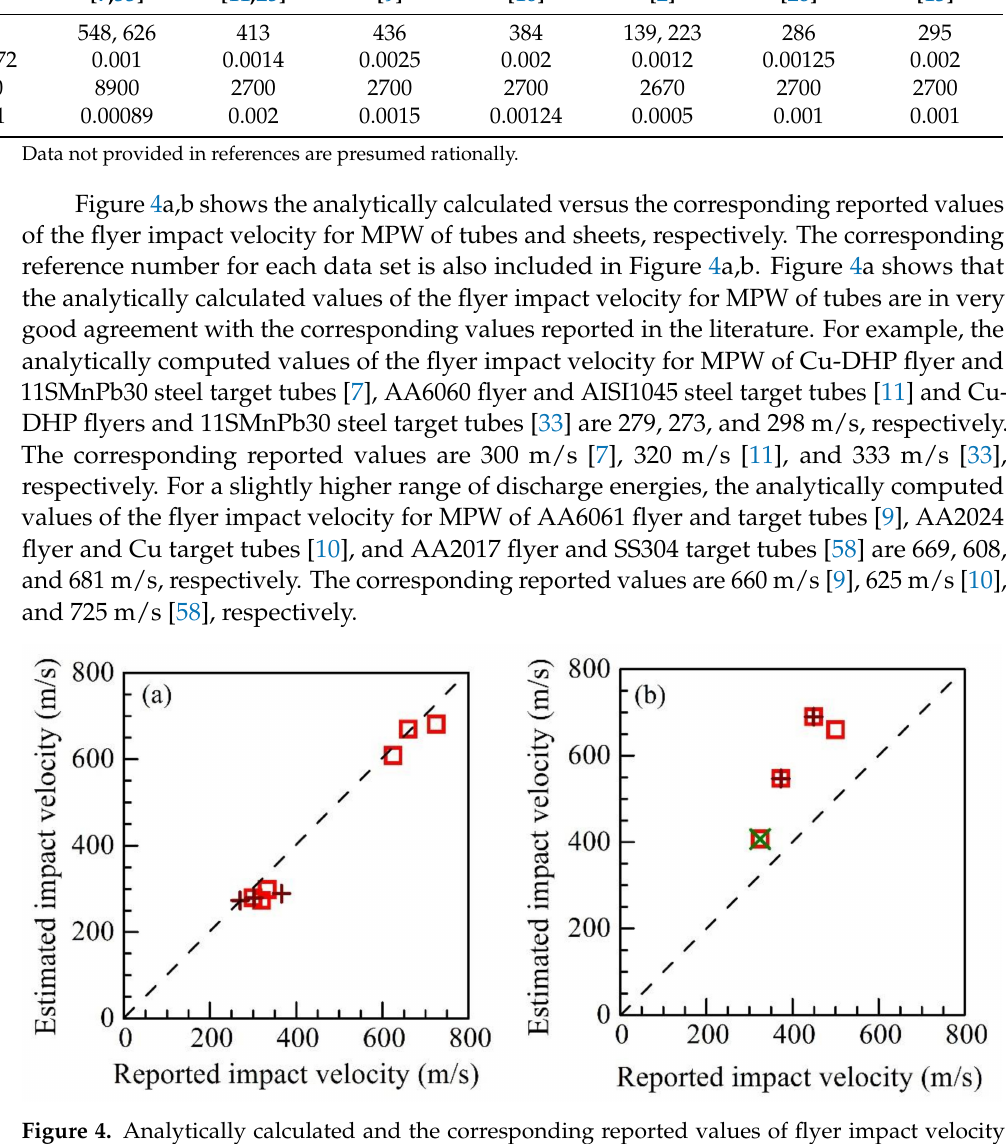
Figure 4. Analytically calculated and the corresponding reported values of flyer impact velocity (v i ) for MPW of ( a ) tubes and ( b ) sheets. The square, cross, and plus symbols depict that the corresponding value(s) from the literature are computed numerically and analytically, as well as measured experimentally. Details of the process conditions and coil geometry details are provided